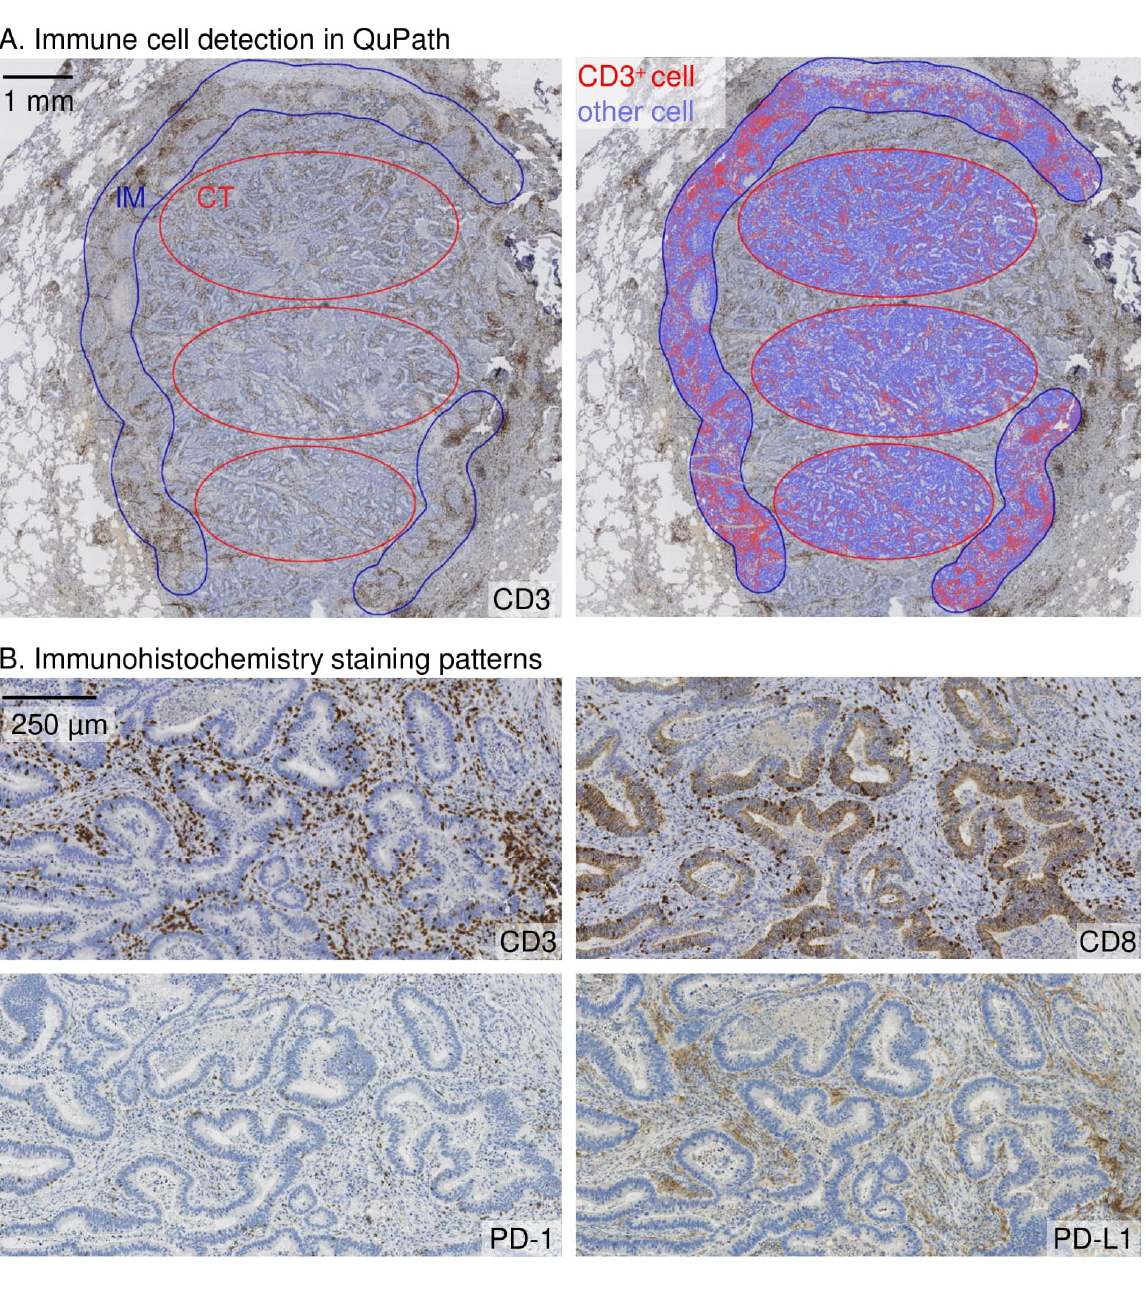
Figure 1. Immune cell density analysis and immunohistochemistry staining patterns in a pulmonary metastasis of colorectal cancer. ( A ). Analysis of immune cell density in the representative sites of the tumour centre (CT) and the invasive margin (IM) sites. The width of the invasive margin was 720 µm spanning 360 µm into the tumour and 360 µm into the healthy tissue. The immune cell density analyses for CD3, CD8 and PD-1 were done in QuPath bioimage software. PD-L1 expression was scored manually. ( B ). Examples of CD3, CD8, PD-1, and PD-L1 staining patterns are represented in the respective site of the tumour.